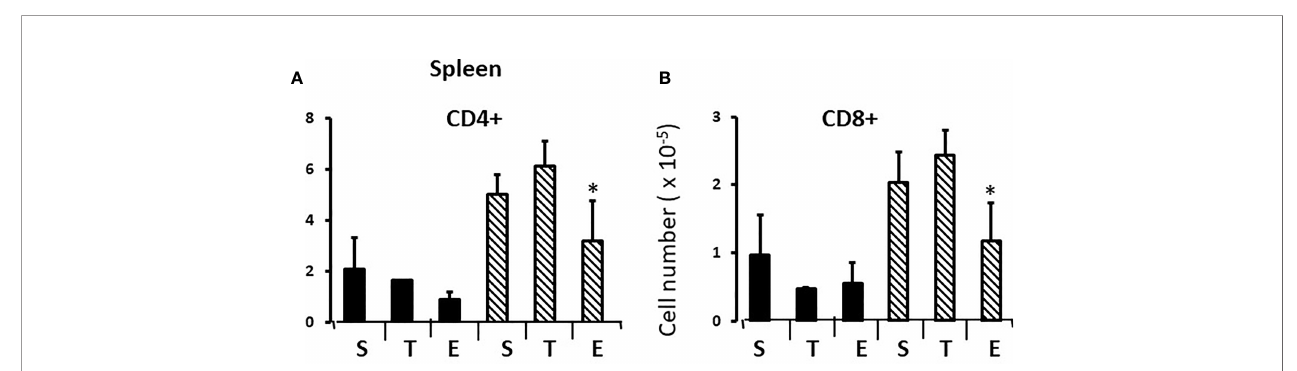
FIGURE 9 | Effect of testosterone and estradiol on cell numbers in the spleen. FCG Mouse pups were treated between days 1 and 7 postpartum before collection of tissues. Data are derived from gated lymphocytes, presented as the mean ± SD, and are derived from 6 males and 5 females in the control group, 3 males and 3 females in the testosterone group and 5 males and 7 females in the estradiol group. S, sesame oil control; T, testosterone; E, estradiol. Males include both XYM and XXM (solid bars) and females include both XXF and XYF (cross-hatched bars). Different from same sex control *p < 0.05, effect size 2.3 and 2.0 for CD4+ and CD8+ cells, respectively.